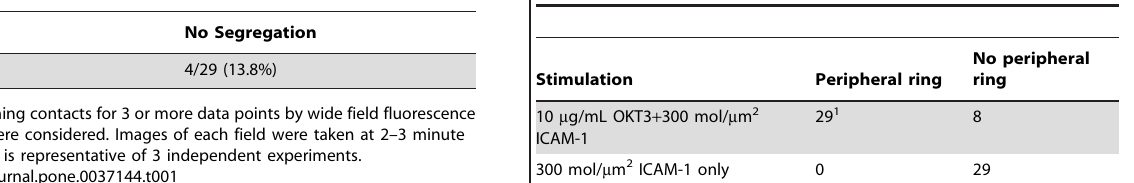
intervals. Data is representative of 3 independent experiments.